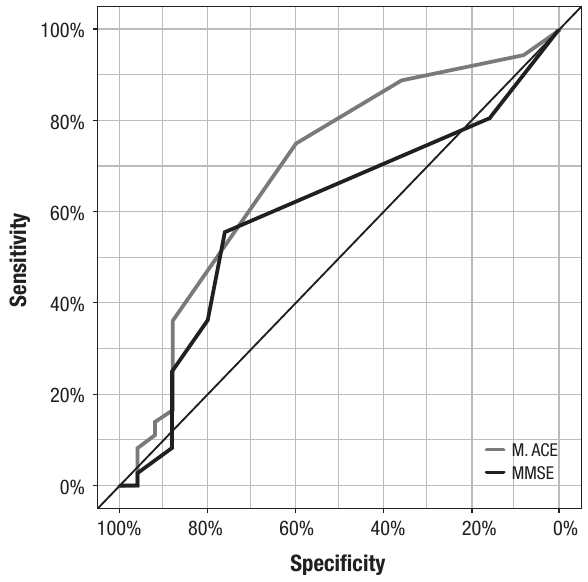
Figure 2. M-ACE and MMSE ROC Curves for differentiating control group from MCI group.